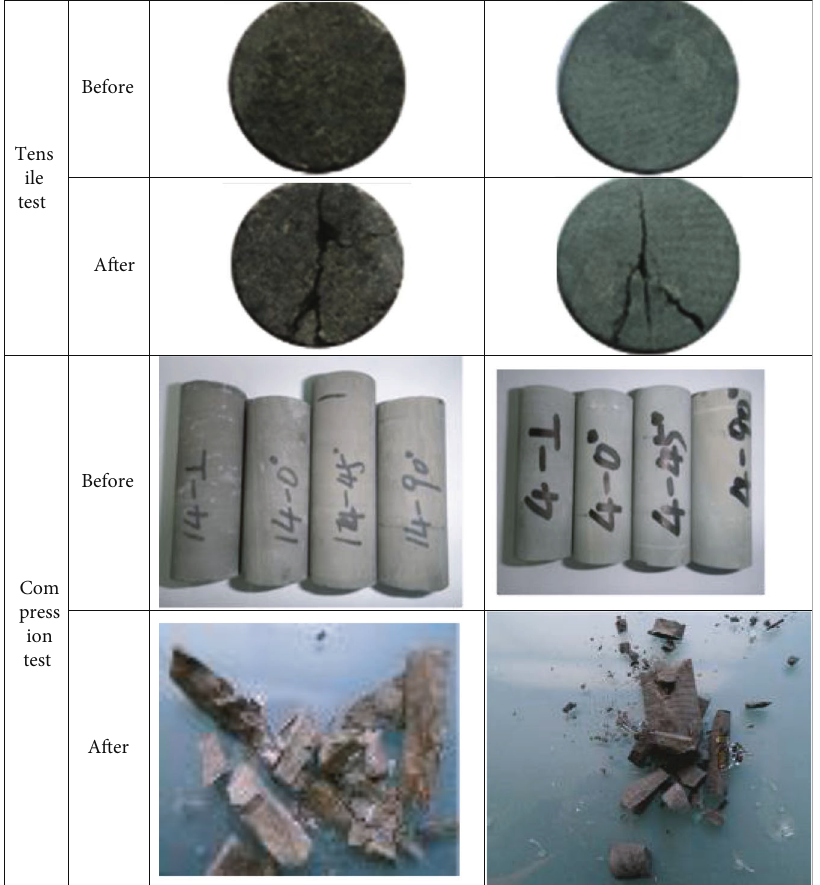
Figure 3: Comparison diagram of rock slices before and after